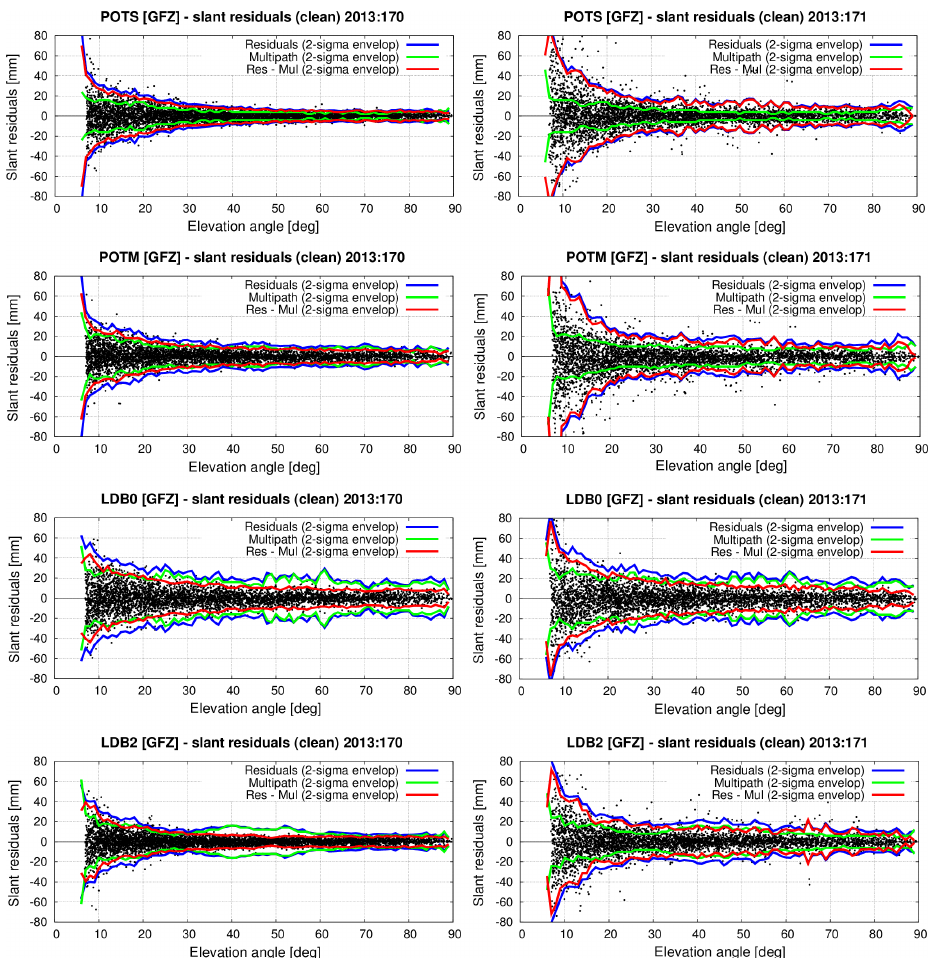
Figure 12. Elevation-dependent variability of clean residuals (black dots) and their 2 σ envelopes (red curves) are showed for 19 June (DOY 171) and 20 June (DOY 170) and four stations: POTS, POTM, LDB0 and LDB2. Additionally, plots display 2 σ envelopes for raw residuals (blue curves) and multipath (green